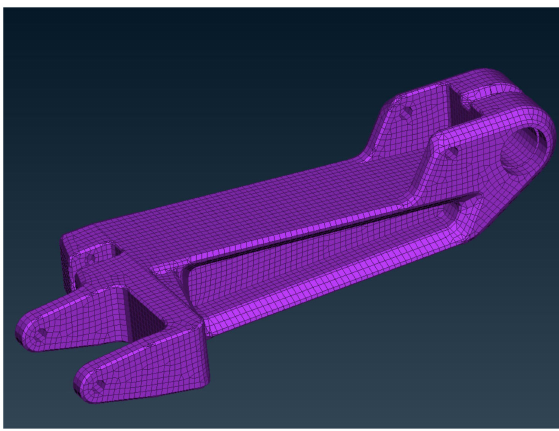
Figure 5. Mesh of the initial swingarm